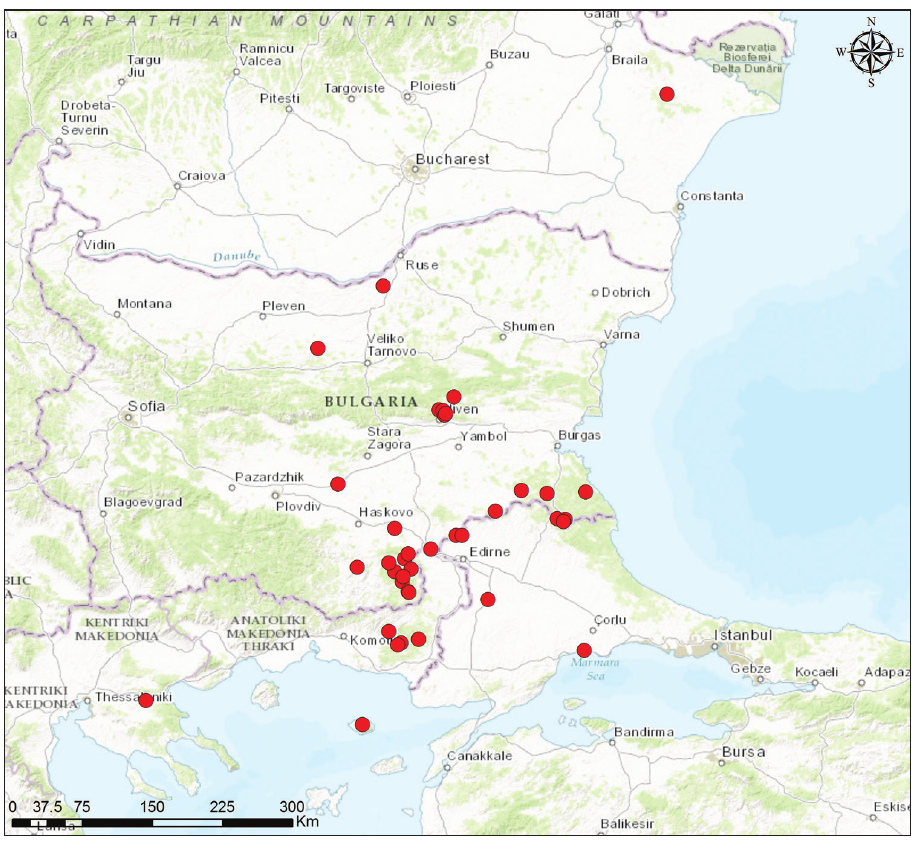
Figure 3. Geographic distribution of Parapholidoptera castaneoviridis in the Balkan Peninsula (for a complete list of localities see the Suppl. material